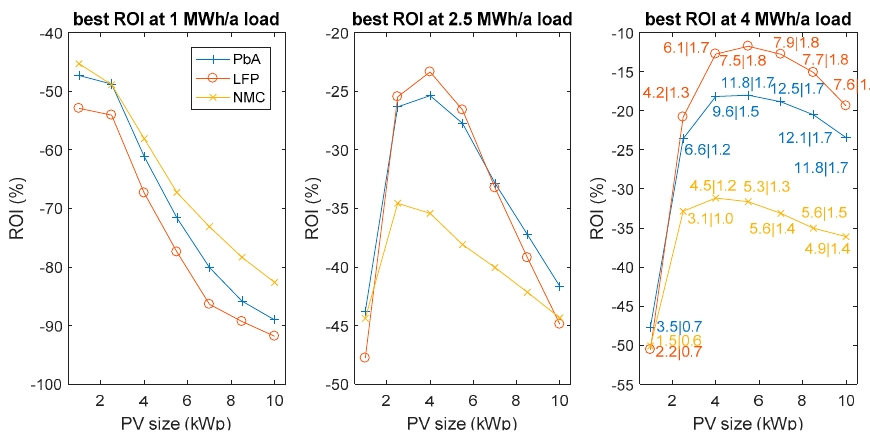
Figure 4. ROI comparison of optimally sized battery energy storage systems at varying PV size for three battery technologies (NMC, PbA, and LFP). Depending on the annual household load demand ( left : 1 MWh/a, center : 2.5 MWh/a, right : 4 MWh/a) different technologies are favored. The inset numbers in the right panel indicate the optimum sizing of battery and inverter for each simulation scenario. Table 6. Return on investment (ROI) optimal sizing of battery and inverter for an average four person household (load demand of 4